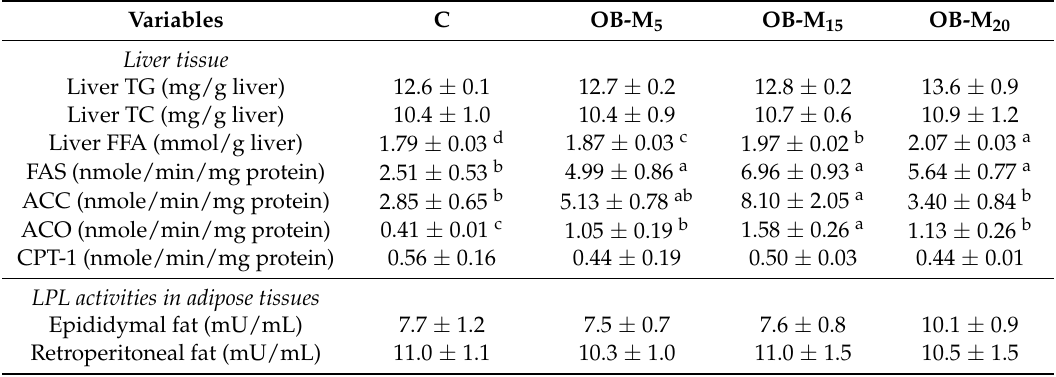
Table 5. Liver lipid profiles, activities of hepatic lipogenic and lipolysis enzymes, and adipose tissue lipoprotein lipase (LPL) activities in obese hamsters after the experimental period for eight weeks.